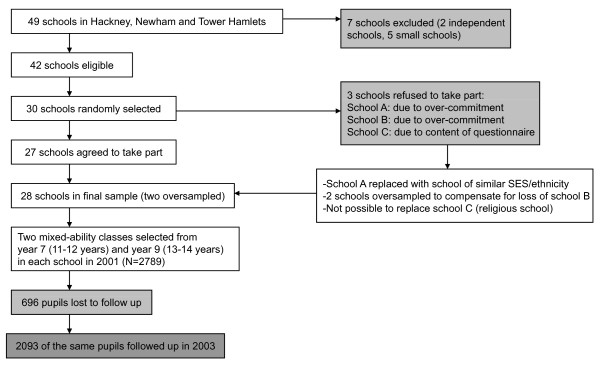
Sampling design.